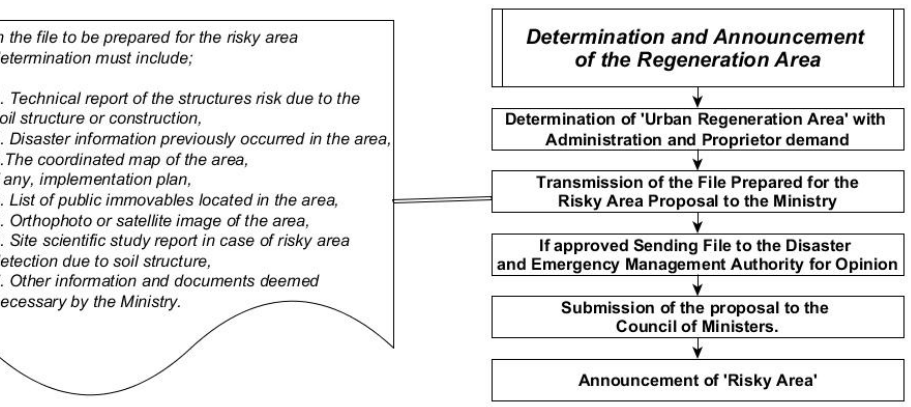
Figure 3. ‘Identification and Announcement of Regeneration Area’ Implementation Steps .